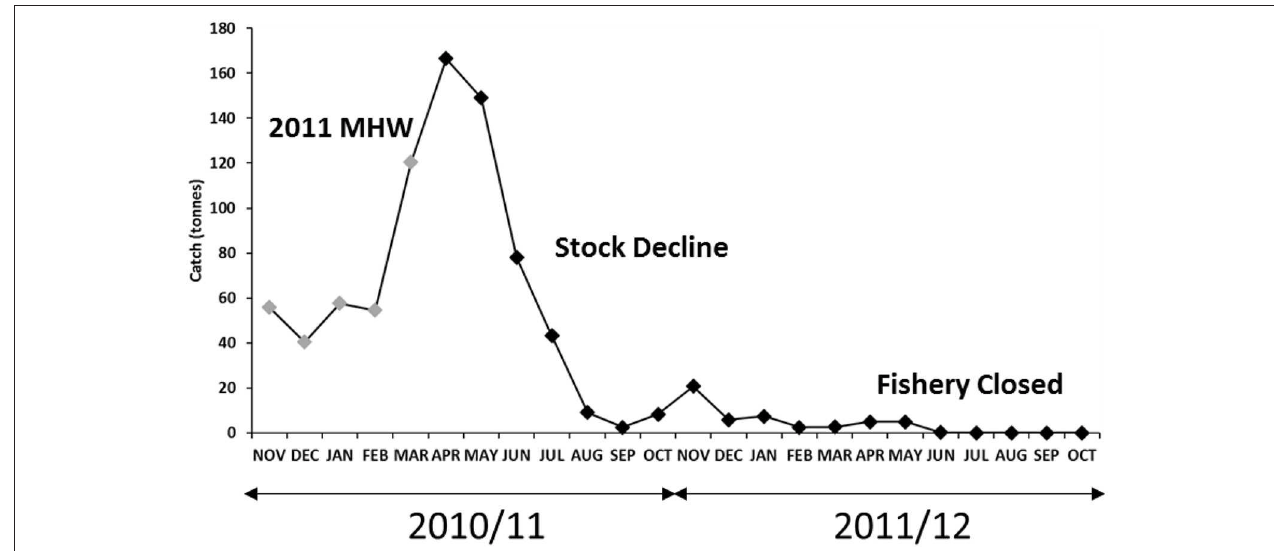
FIGURE 2 | Monthly crab catches during the 2010/11 and 2011/12 fishing seasons showing catches landed during the 2011 MHW (gray), stock decline (low abundance August 2011 onwards), and fishery closure (April/May 2012).